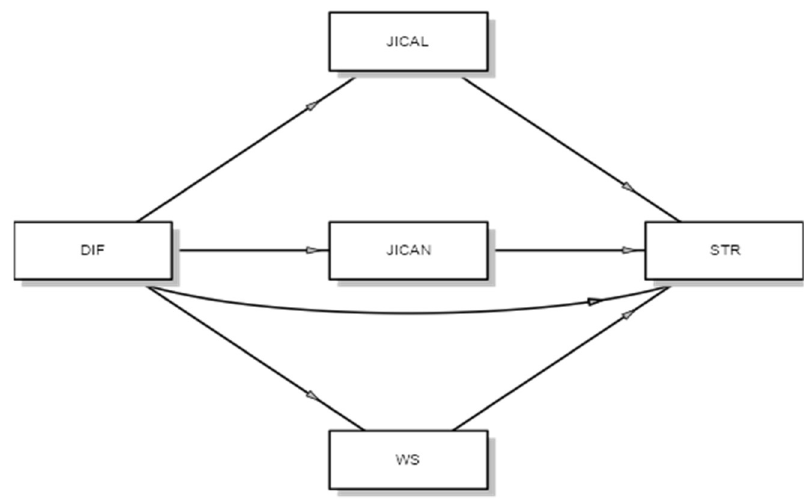
Figure 3. Model diagram for qualitative and quantitative job insecurity, and work meaning as mediators in the relationship between material difficulties and stress.